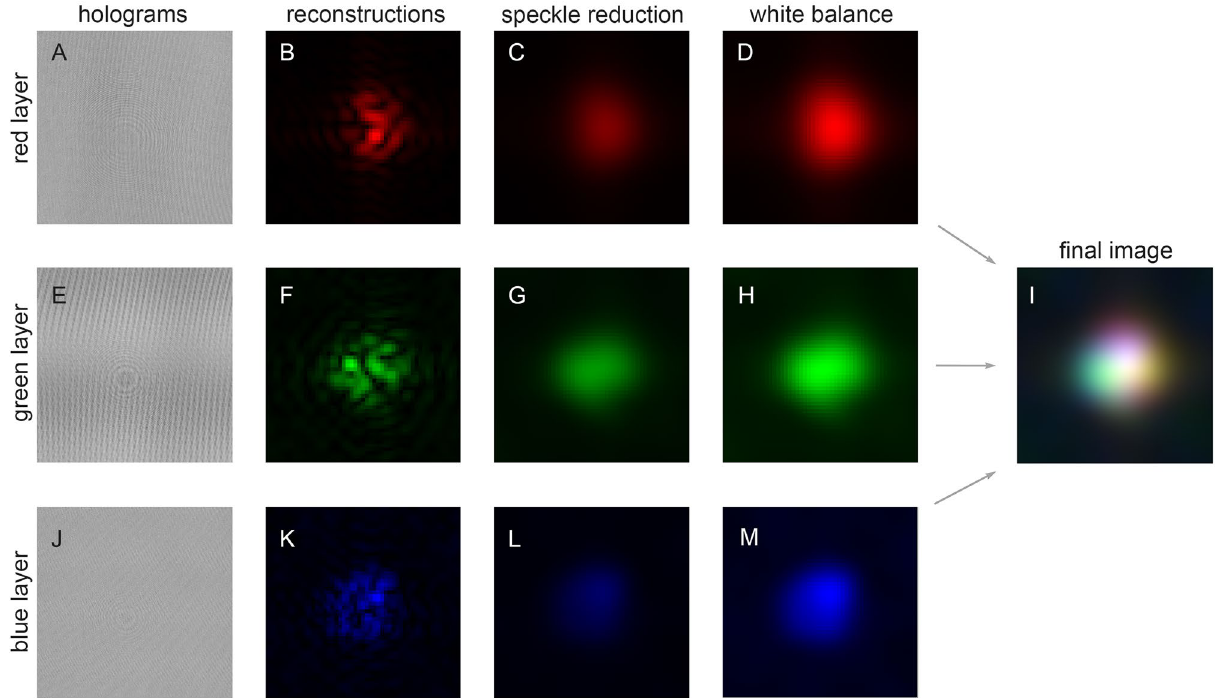
Figure 7. Backscatter MWDH image-generation process. The backscatter contrast holograms H con i measured for a 50 µ m white spherical aerosol particle are shown in the first column ( A,E,J ). This particle establishes the WB and is the same particle presented in Fig. 2A. Note that the interference fringes attributed to the particle are difficult to see due to the weak intensity of the backscattered light. Close examination of the holograms shows a faint cluster of nested circular fringes, which are due to the particle, and the most visible example is near the center of hologram ( E ). The second column ( B,F,K ), shows the image layers reconstructed from these holograms, where speckle is evident. Applying the speckle-reduction process yields the images in the third column ( C,G,L ), which are then white-balanced to give the images in the forth column ( D,H,M ). The three processed image-layers ( D,H,M ), are then combined via color addition to give the final particle image shown in ( I